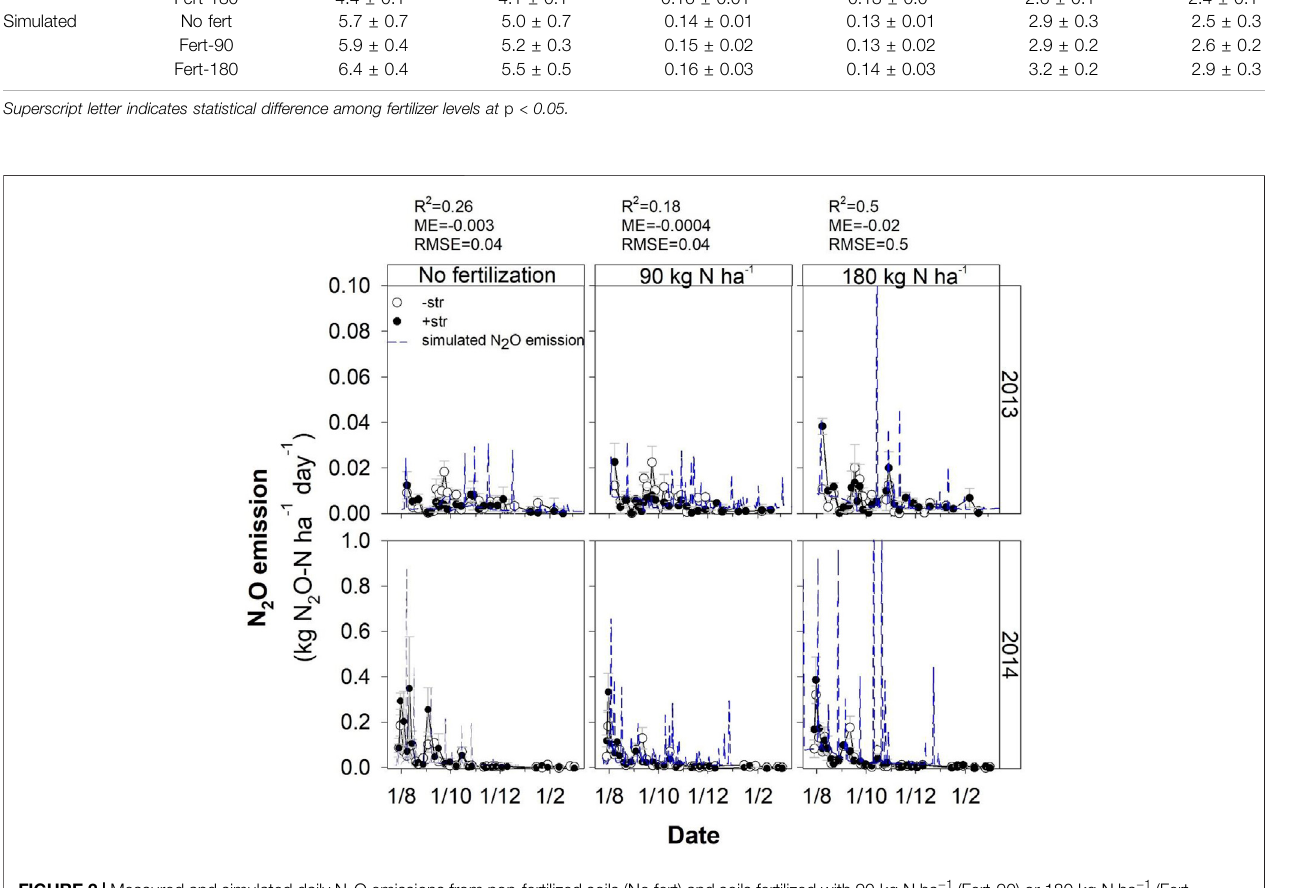
FIGURE 2 | Measured and simulated daily N 2 O emissions from non-fertilized soils (No fert) and soils fertilized with 90 kg N ha − 1 (Fert-90) or 180 kg N ha − 1 (Fert- 180) in spring. In all soils straw was quanti fi ed and either removed (-str) or placed back in the respective fertilized soils (+str). Sampling period was from August 2013 to March 2014 and August 2014 to March 2015. Numbers above the panel describe the quality of the COUP model for the respective fertilizer treatment. Error bars show the standard error of mean of each treatment ( n (cid:2)